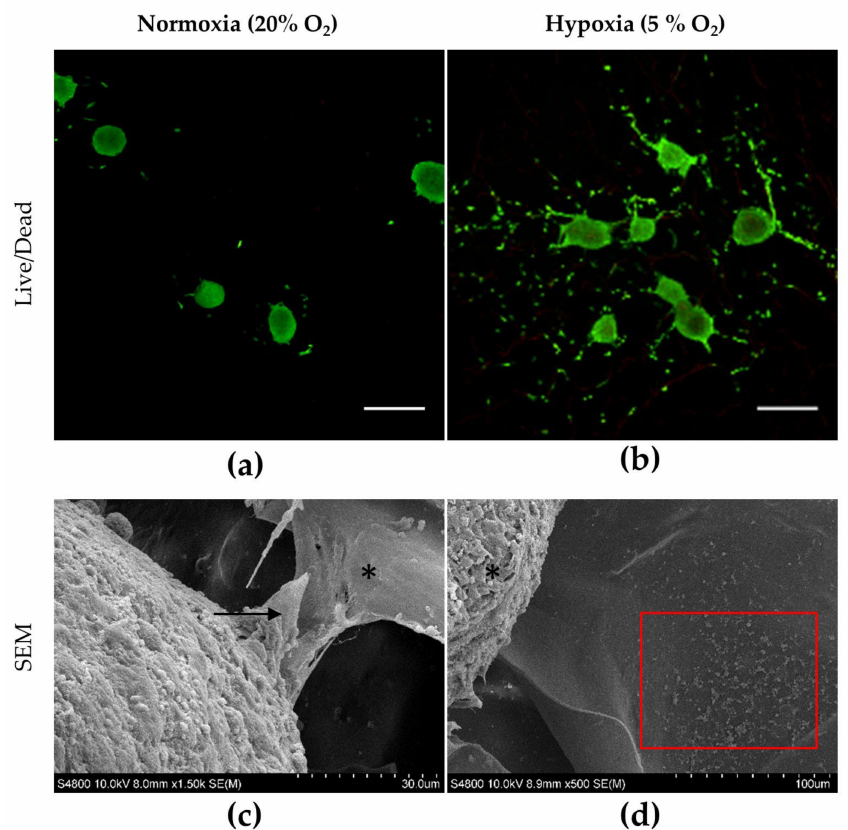
Figure 4. Viability (Live / Dead assay) of adhered hASC spheroids cultured in CM for 7 days in contact with the 3D porous CS / CHNC sca ff old studied under ( a ) normoxia and ( b ) hypoxia. Images of hASC spheroids adhered (SEM) to the aforementioned biomaterial at 7 days under ( c ) normoxia and ( d ) hypoxia. The asterisks (*) indicate the sca ff old and the arrows the interaction between the cells forming the spheroids and the biomaterial. The red square represents individual cells that have egressed from the spheroid under hypoxia conditions. Scale bar in the fluorescence images represents 500 µ